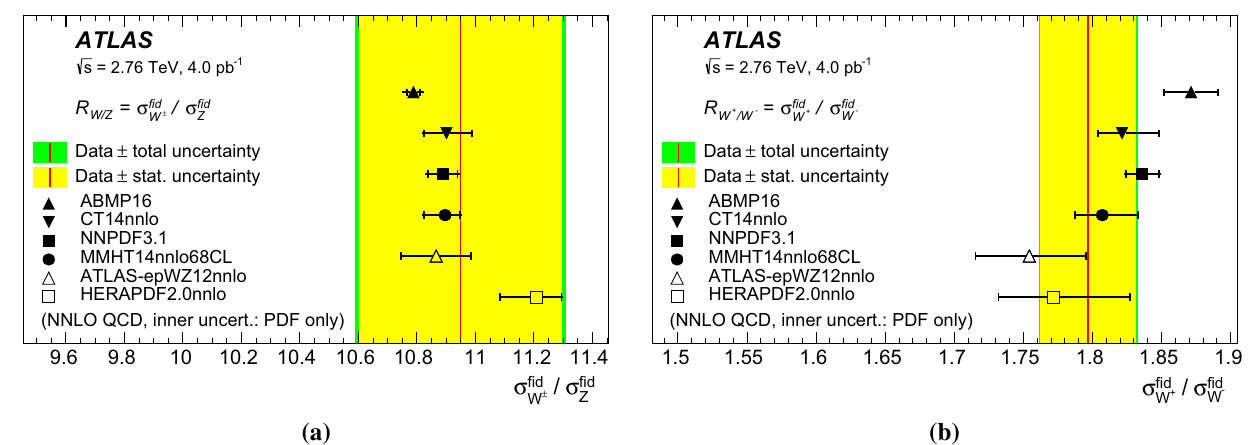
Fig. 7 The measured ratio of fiducial cross-sections for (a) W -boson production to Z -boson production, (b) W + -boson production to W − - boson production. The measurements are compared with theoretical predictions at NNLO in QCD based on a selection of different PDF